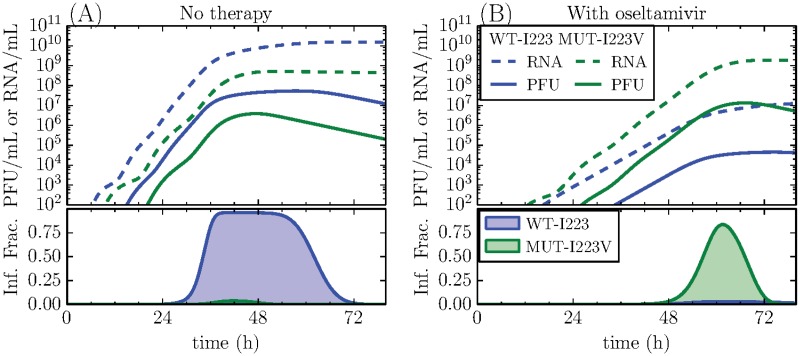
Simulated competition between the WT-I223 and MUT-I223V strains.The infectious (PFU/mL) and total (RNA/mL) viral load (top), and the fraction of infectious cells infected by each strain (bottom) are shown. The curves are produced using the median values of the extracted MCMC distributions. (A) In the absence of therapy, the mutant is disadvantaged due to its longer eclipse phase (τ
E), and shorter infectious lifespan (τ
I). (B) In the presence of oseltamivir, the mutant gains the fitness advantage. The quantitative gains or losses of each strain along with statistical significance are provided in the Appendix.